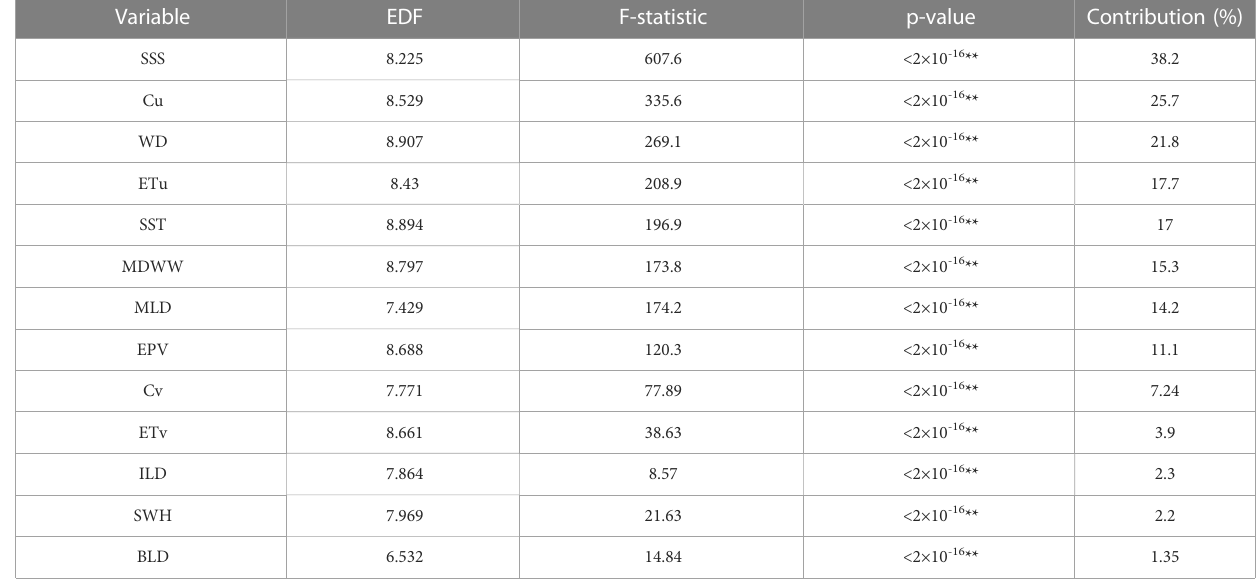
TABLE 1 GAM fi tting results of SDD and environmental factors.